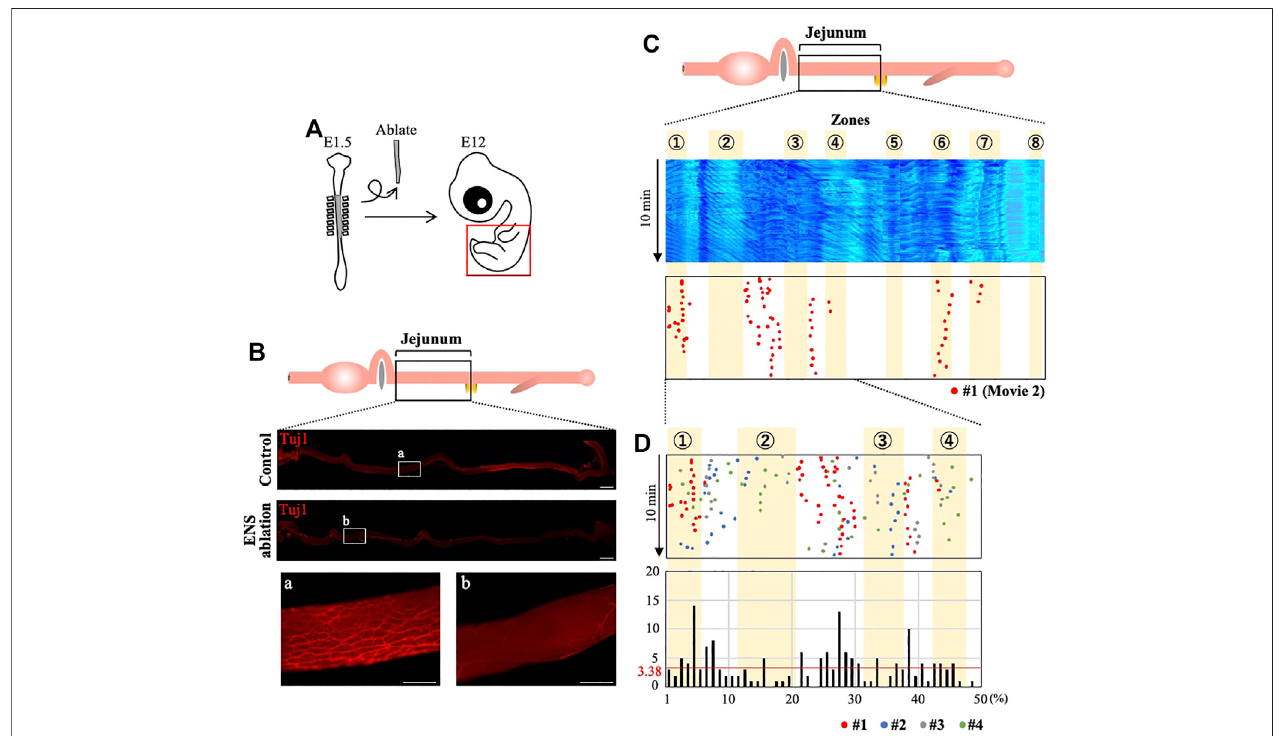
FIGURE 4 | Enteric nervous system (ENS) is required for the correct distribution of OPW in the jejunum. (A) Neural crest cells that would normally contribute to the ENS are deprived by ablating the neural tube at the vagal level. (B) ENS-ablated jejunum at E12 stained with Tuj1: whereas meshwork structures of ENS are seen in control(non-ablated)specimen(a),ENS-ablated jejunum showsnoor littleENS(b). (C) Kymograph and mapofOPW distribution forthe#1specimen(reddots) ofENS- ablated jejunum. (D) Overlaid map for specimens #1 – #4 (red, blue, gray, green) in the anterior jejunum (50 positions), which would normally contain the four zones (1 – 4). The total number of OPWs is 169, and the average number is 3.38 (horizontal line in red). Many OPWs are found out-of-zone in an aberrant manner. Scale bars: 2 mm (low magni fi cation) and 500 μ m (high magni fi cation).